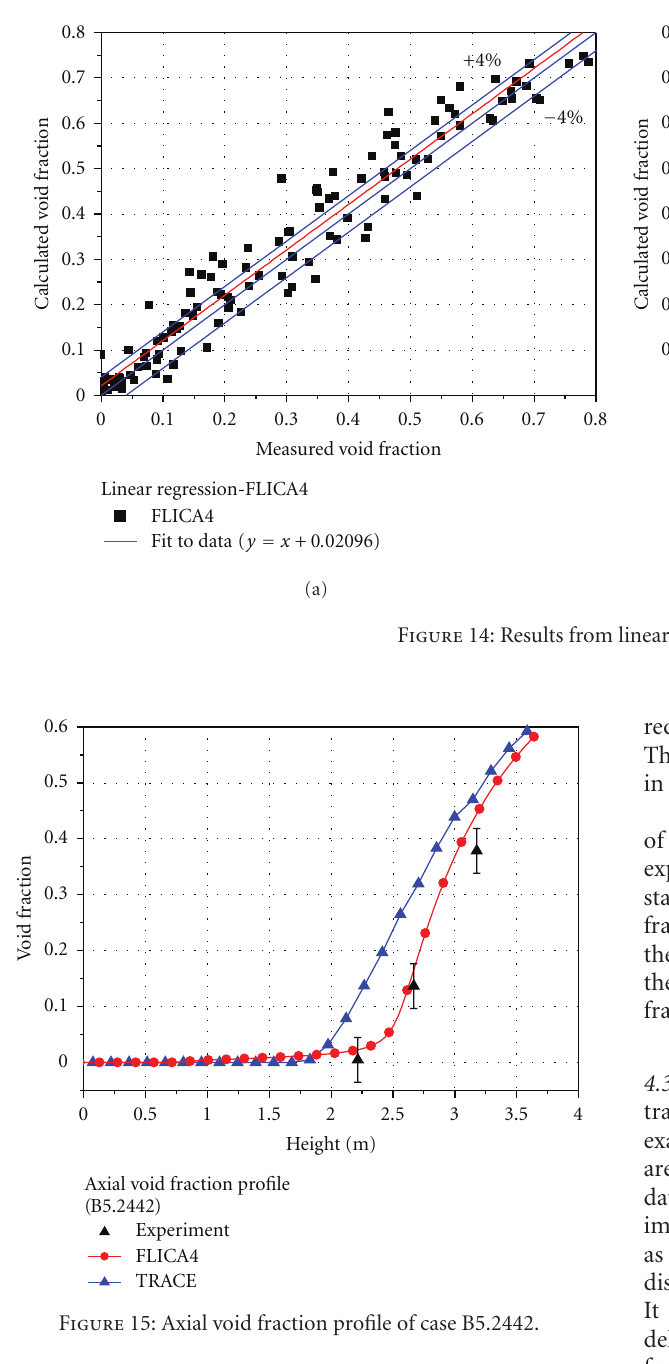
boiling model and bulk condensation model in